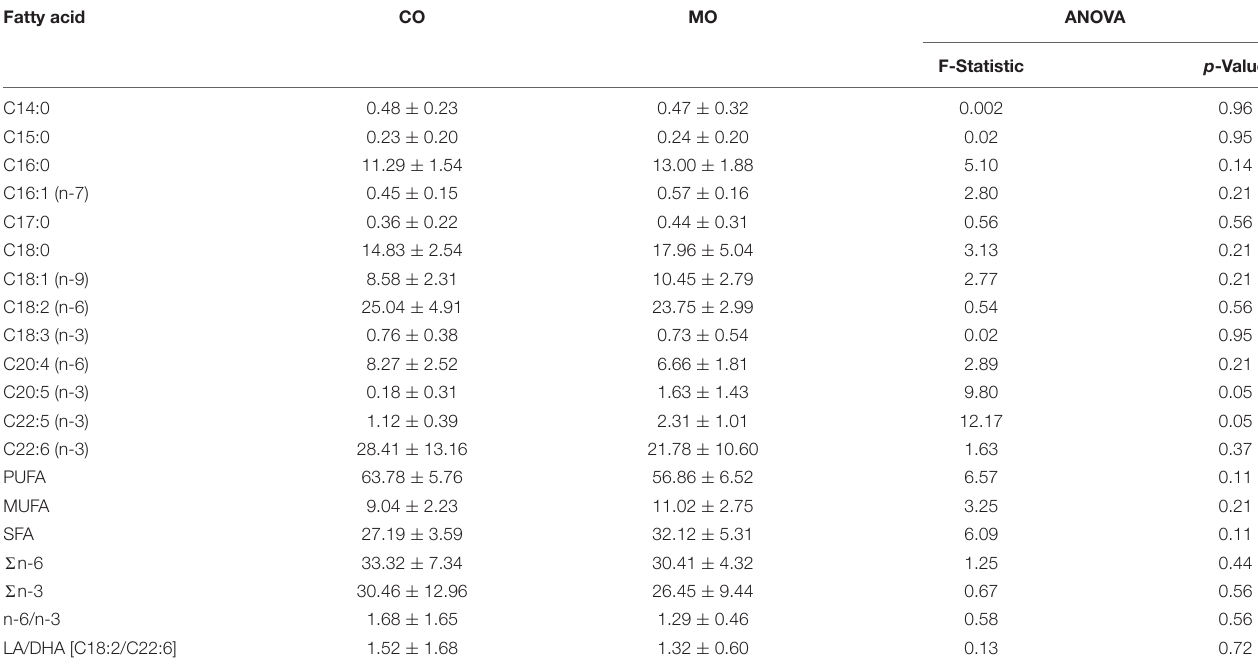
TABLE 6 | Fatty acid proportions (% of total fatty acids), at mid-hibernation, of cardiac sarcoplasmic reticulum phospholipids (means ± standard deviation) and ratios of certain fatty acid proportions of garden dormice fed diets enriched with either n-6 fatty acids (“CO”) or n-3 fatty acids (“MO”). Fatty acid CO MO ANOVA